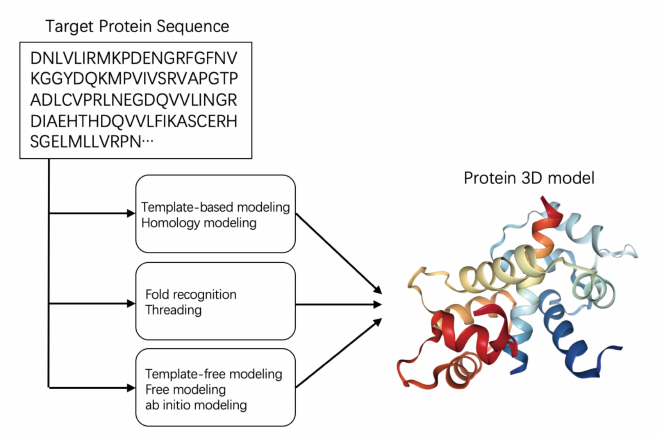
Figure 2. Three approaches of protein structure